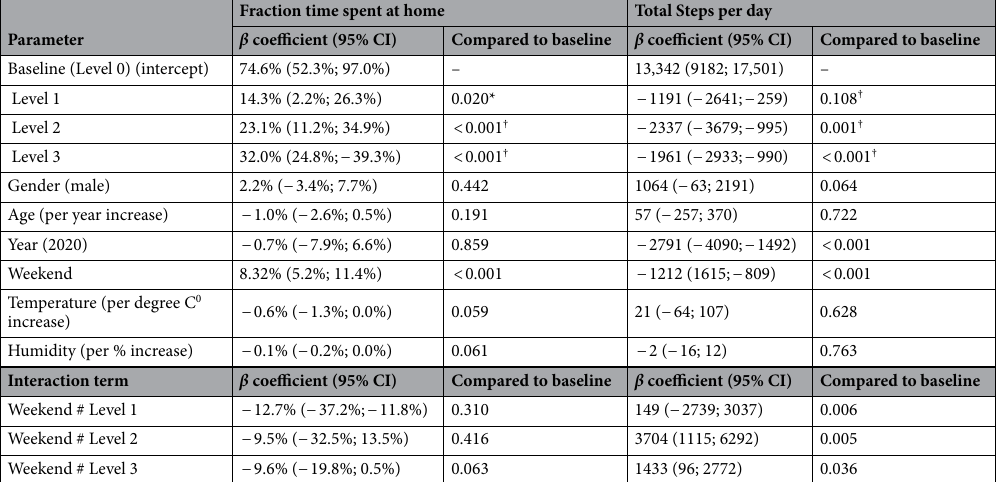
Table 4. Fraction time spent at home and total steps per day in response to interventions for Covid-19 among asthmatic children in Greece. * p = 0.020, compared to previous level. † p > 0.05, compared to the previous